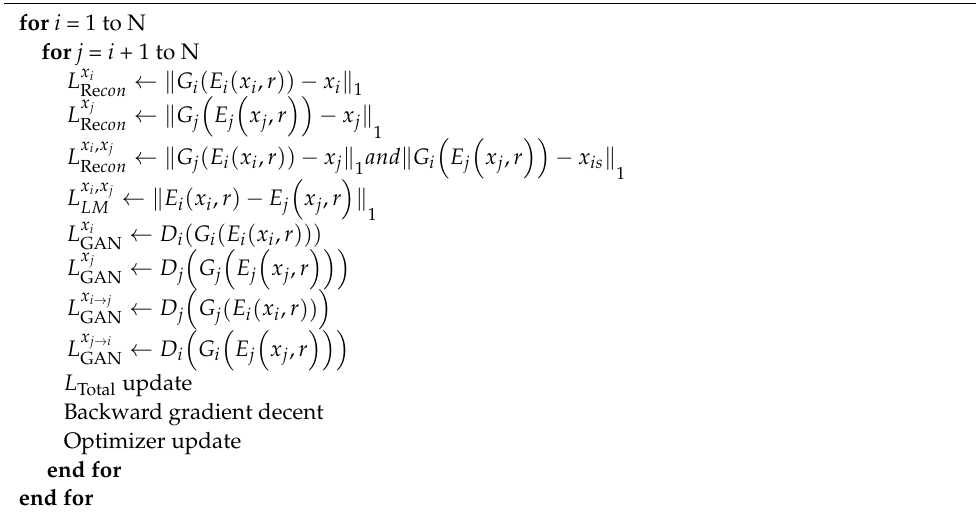
Algorithm 1. Generators training process in a single